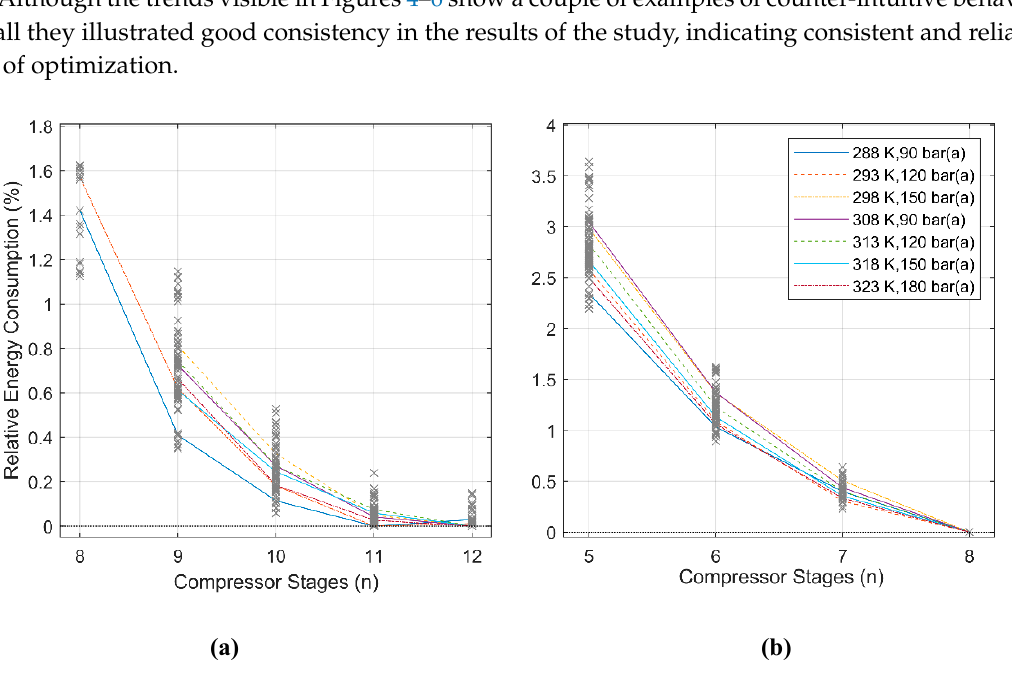
Figure 5. Relative energy consumption vs. stages for pre-combustion capture, (a) constrained cases and (b) unconstrained cases.